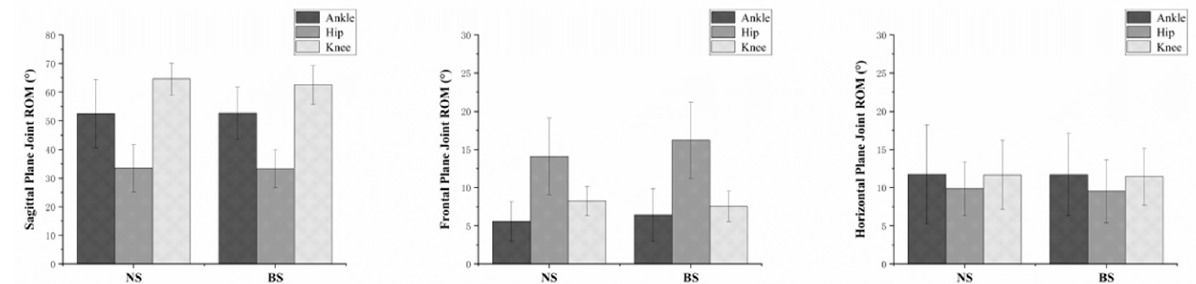
Figure 9. Comparison of the ankle, hip, and knee on the sagittal, frontal, and horizontal plane range of motion during the SLL phase.